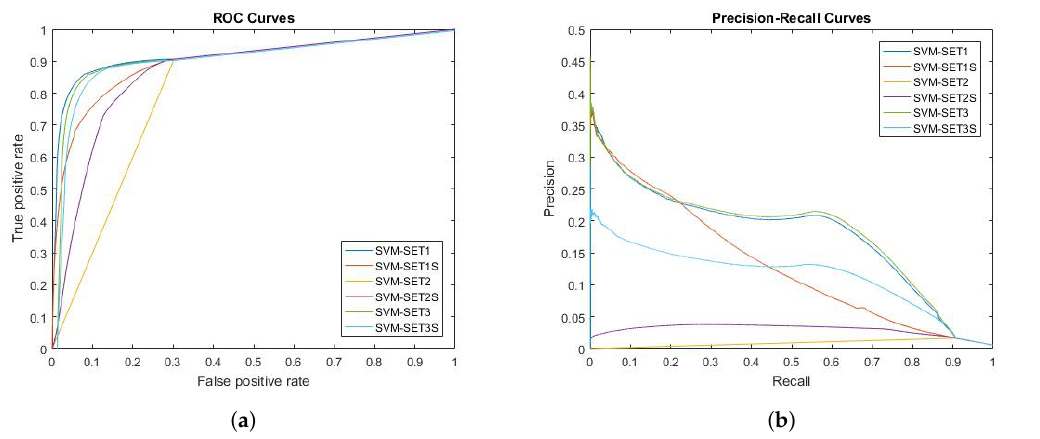
Figure 4. Receiver operating characteristic (ROC) and precision-recall (PR) curves of SVM for all evaluated voxels. Six different ways of extracting features from MRI are tested and evaluated in this experiment. ( a ) ROC curve of SVM; ( b ) PR curve of